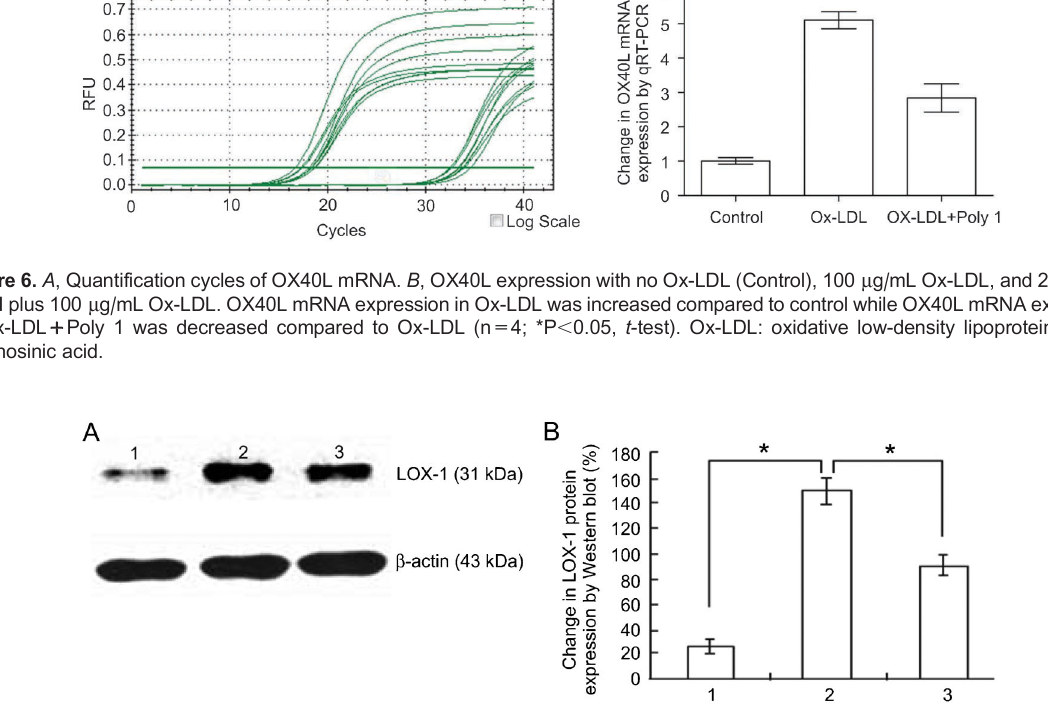
Figure 7. A , LOX-1 expression levels in HUVECs treated with 1) no Ox-LDL (untreated control); 2) 100 m g/mL Ox-LDL, and 3) 250 m g/ m L Poly I plus 100 m g/mL Ox-LDL. B , The expression of LOX-1 in group 2 was increased compared to group 1. LOX-1 protein expression in group 3 was decreased compared to group 2 (n=4; *P , 0.05, t -test). LOX-1: oxidized low-density lipoprotein-1 receptor; HUVECs: human umbilical vein endothelial cells; Ox-LDL: oxidative low-density lipoprotein; Poly I: polyinosinic